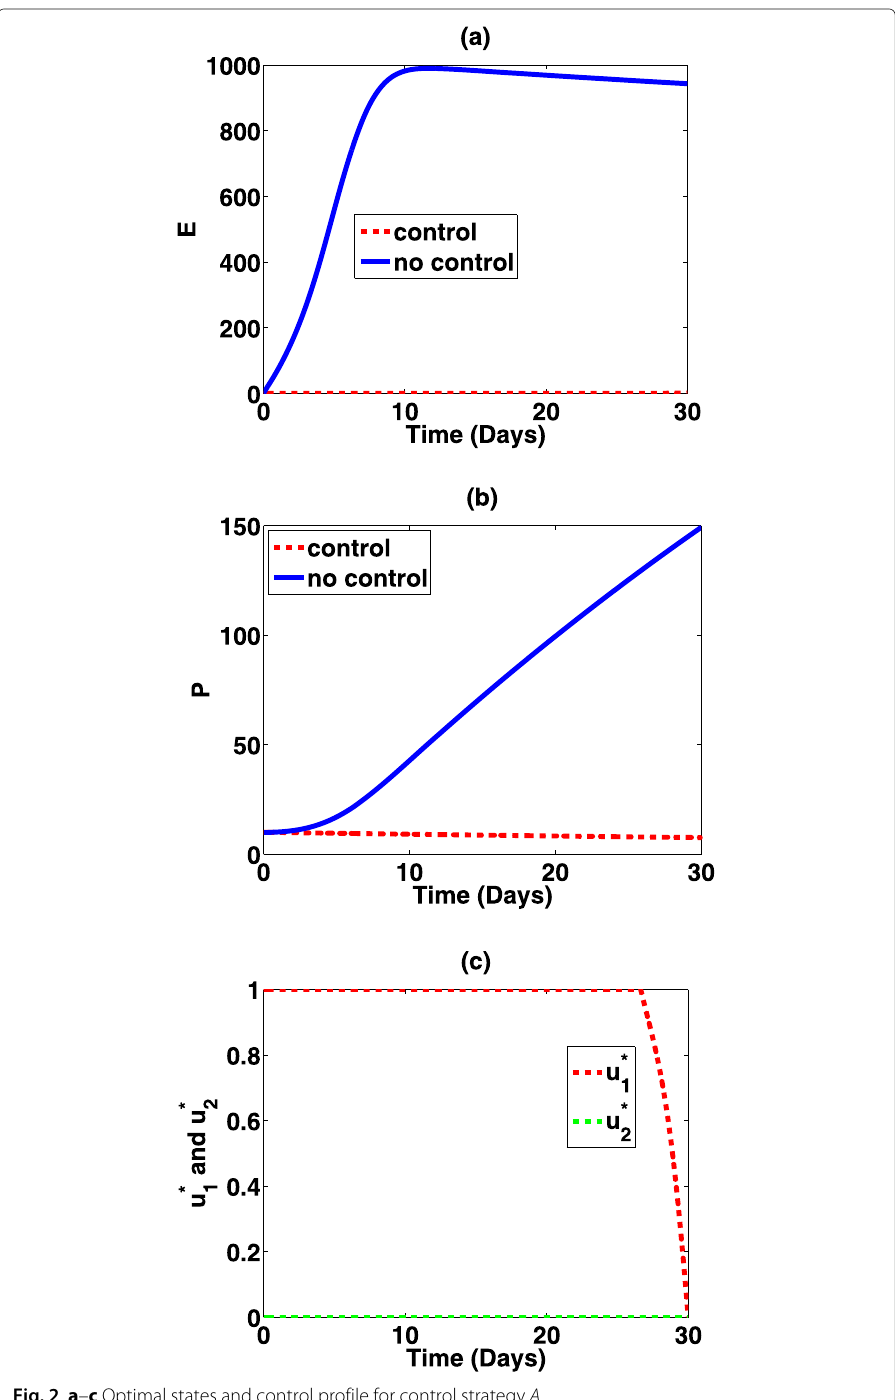
Fig. 2 a – c Optimal states and control profile for control strategy A can be greatly reduced. The control of the environmental decontamination u 2 is at zero because in this strategy, only the control of vaccination u 1 is active. Strategy B: optimal use of environmental decontamination With this strategy, only the control of environmental decontamination u 2 is used to opti- mize the objective function (41) while the control of vaccination u 1 is set to zero.